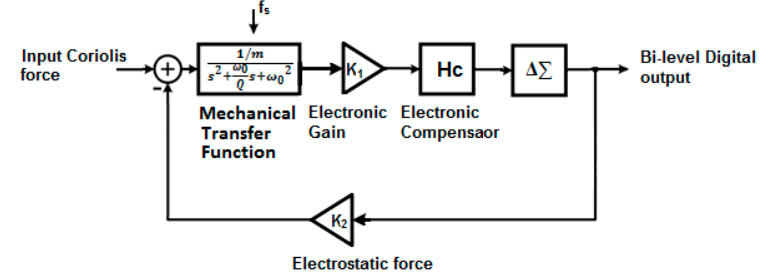
Figure 2. Structure of a typical Δ∑ modulator-based MEMS gyroscope.